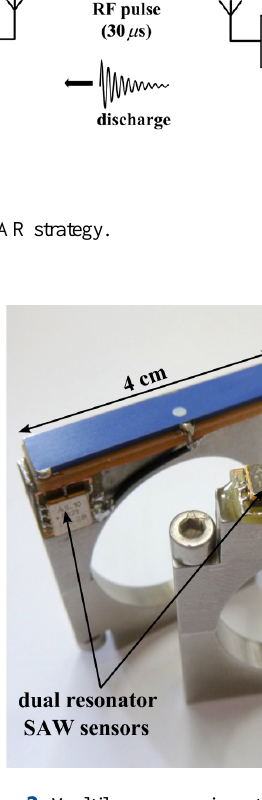
Figure 2. Multilayer ceramic antennas connected to double reso- nance SAW temperature sensors on steel